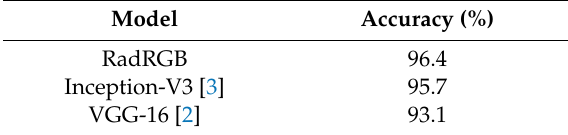
Table 5. Performance of RadRGB, VGG-16, and Inception-V3 models on the RGB-ROI